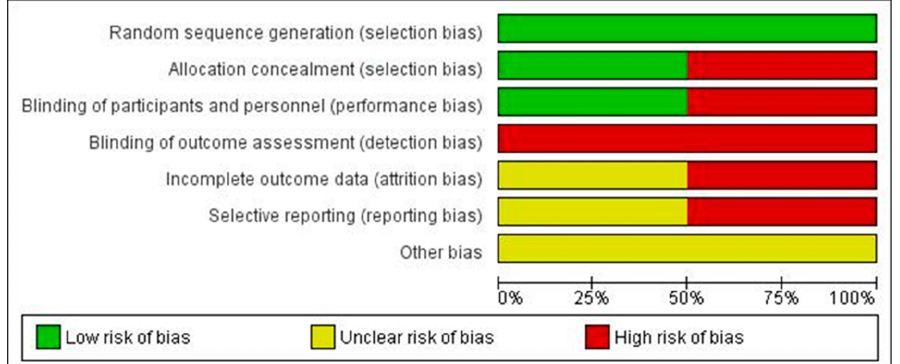
Figure 3. Risk of bias in randomized controlled trials using Cochrane risk of bias tool.